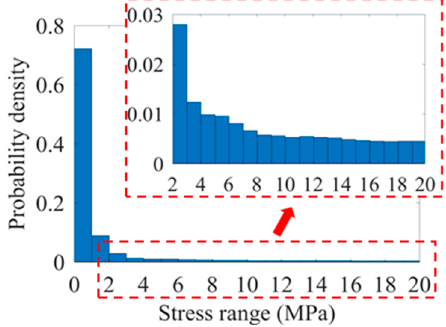
Figure 17. Hot spot stress spectra of the joint U13 L .